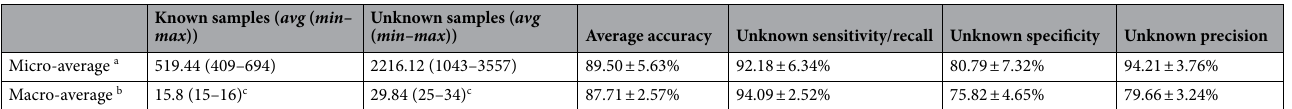
Table 1. Micro- and macro-averaged metrics of the novelty detection algorithm on the test set using 50-fold validation. a Micro-average refers to the metric calculated without regard to species as an independent class: each sample has an equal weight. b Macro-average refers to the metric calculated first within each species as an independent class, then averaged between species for the known or unknown classes, in order to address imbalance of samples between species. c This indicated the number of species in the known or unknown classes for each